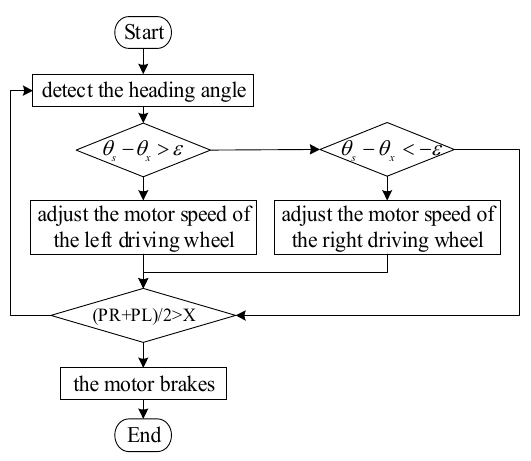
Figure 17. The correction process when the robot chassis moves in a straight line.